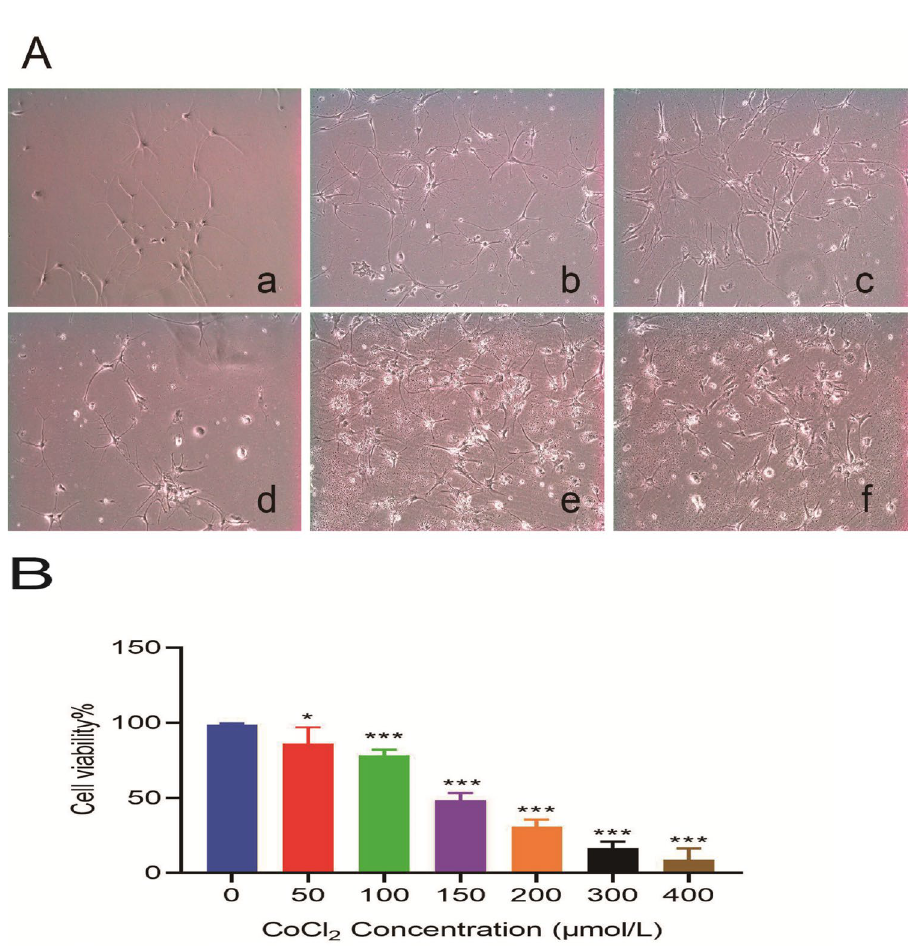
Figure 2. ( A ) Cell morphology of hippocampal neuronal cells treated with different concentrations of CoCl2 for 24 h (× 200) (a, b, c, d, e, f respectively represent 50 μmol/l, 100 μmol/l, 150 μmol/l, 200 μmol/l, 300 μmol/l, 400 μmol/l CoCl2 group). ( B ) Cell viability of hippocampal neuronal cells treated with different concentrations of CoCl2 for 24 h (n = 6 for every group, * P < 0.05, *** P < 0.001 vs. normal group by one-way